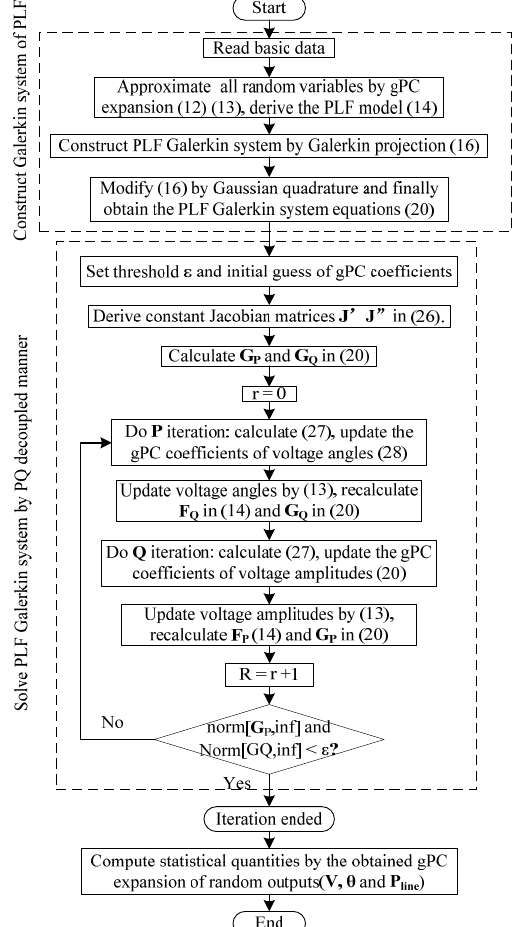
Figure 3. Flow chart of the proposed SG ‐ PLF method.